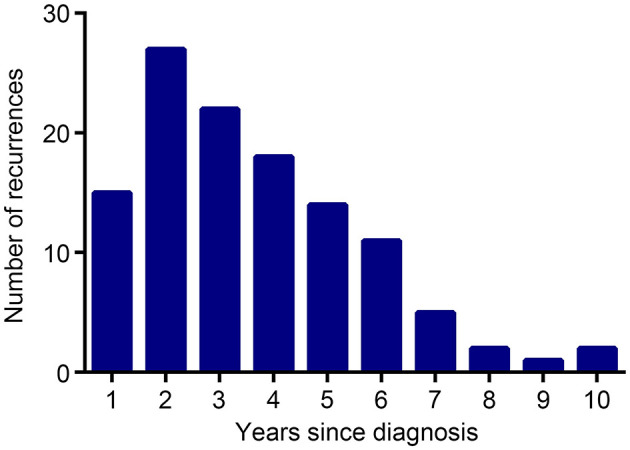
Number of recurrences by year of entire patients.